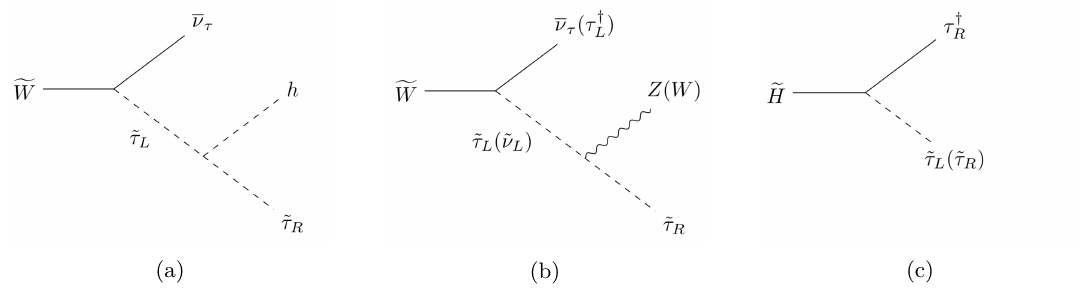
Figure 2. Main wino and higgsino decay channels. All decay channels of MSSM particles end in a state involving the lightest stau which decays into tau, twin tau and twin stau, as shown in figure